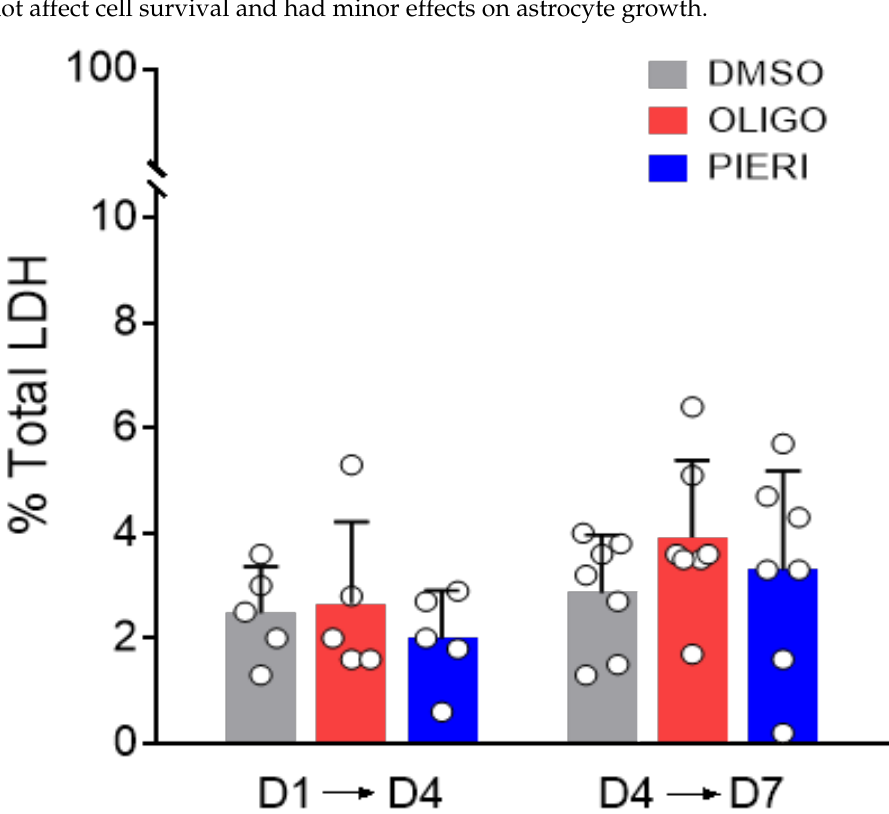
Figure 5. Lactate dehydrogenase (LDH) concentration in the medium after culturing astrocytes with mitochondrial inhibitors. Astrocytes were cultured in Medium 3, containing DMSO (0.025%, v/v ; solvent), oligomycin (OLIGO; 1 µ g/mL), or piericidin A (PIERI; 2 µ M) from day one (D1). The culture media were replaced at days one (D1) and four (D4). Therefore, media for LDH quantification were collected 72 h after medium replacement, thus at D4 (D1 → D4) and/or at D7 (D4 → D7). N =